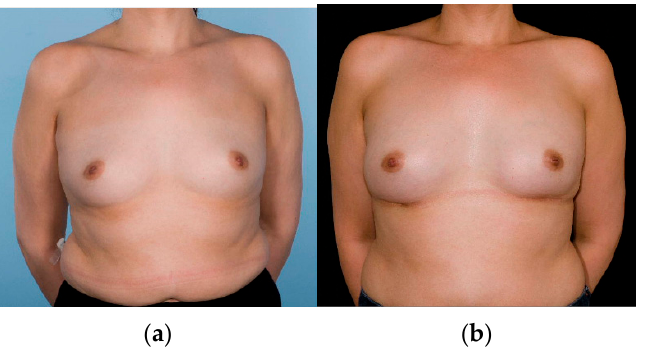
Figure 1. Example of a woman who underwent nipple-sparing mastectomy with implant-based reconstruction in the sub-muscular position with lower pole support using acellular dermal matrix. Pre-operative photograph ( a ) and post-operative photograph ( b ).